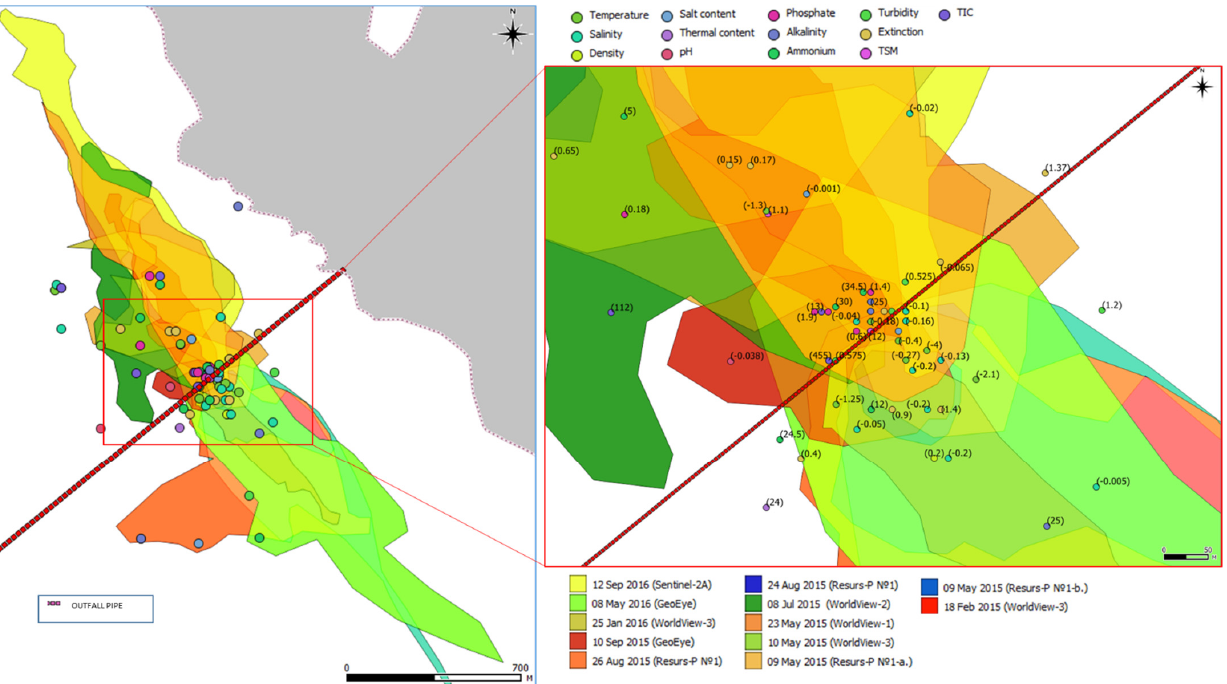
Figure 11. The schematic map illustrating the spatial position of the results of submerged plume detection according to satellite multispectral data (colored polygons) and the points of registered maximum levels of anomalies of the water environment’s significant parameters according to sea truth measurements (colored circles) in the test area. Actual deviations of the measured parameters from the background values are given in brackets in the enlarged fragment.